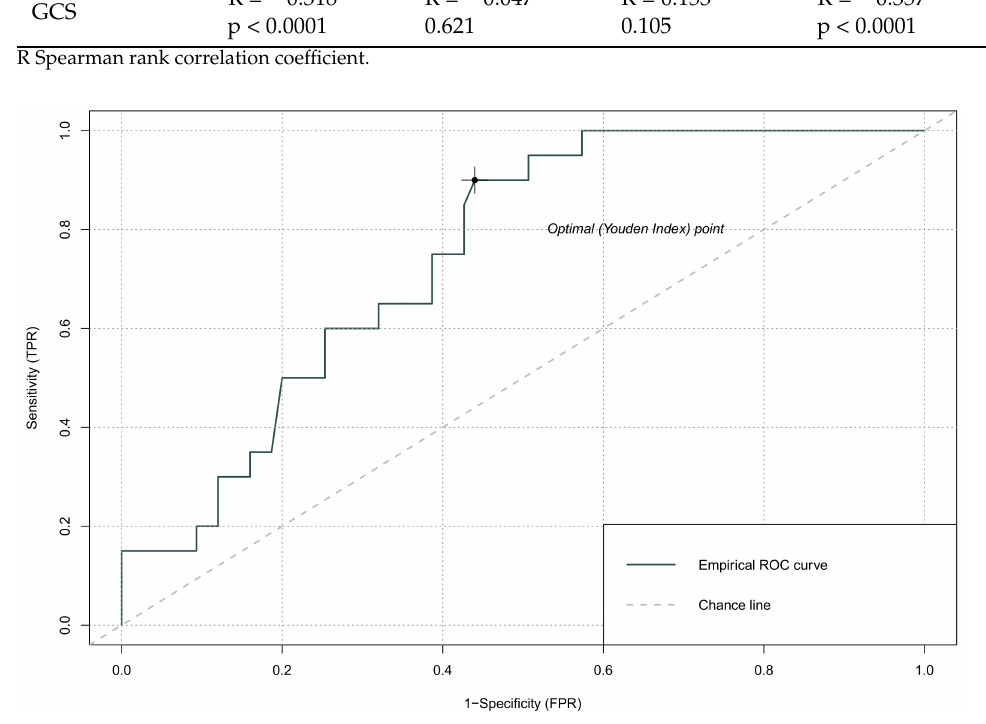
Figure 1. ROC curve analysis for admission GCS score and NLR; FPR—false positive rate, TPR—true positive